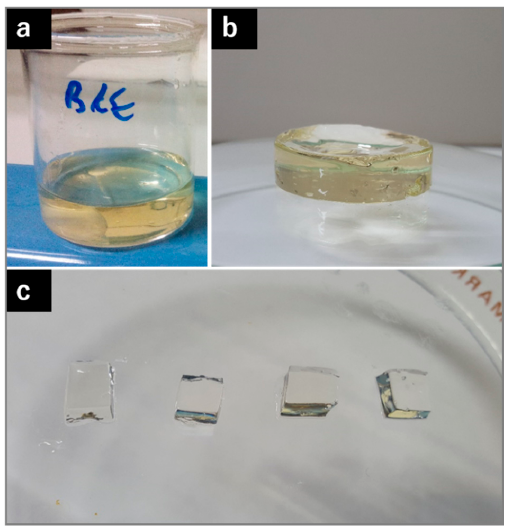
Figure 1. ( a ) Newly fabricated BCE hydrogel; ( b ) extracted hydrogel; and ( c ) hydrogel fractions.